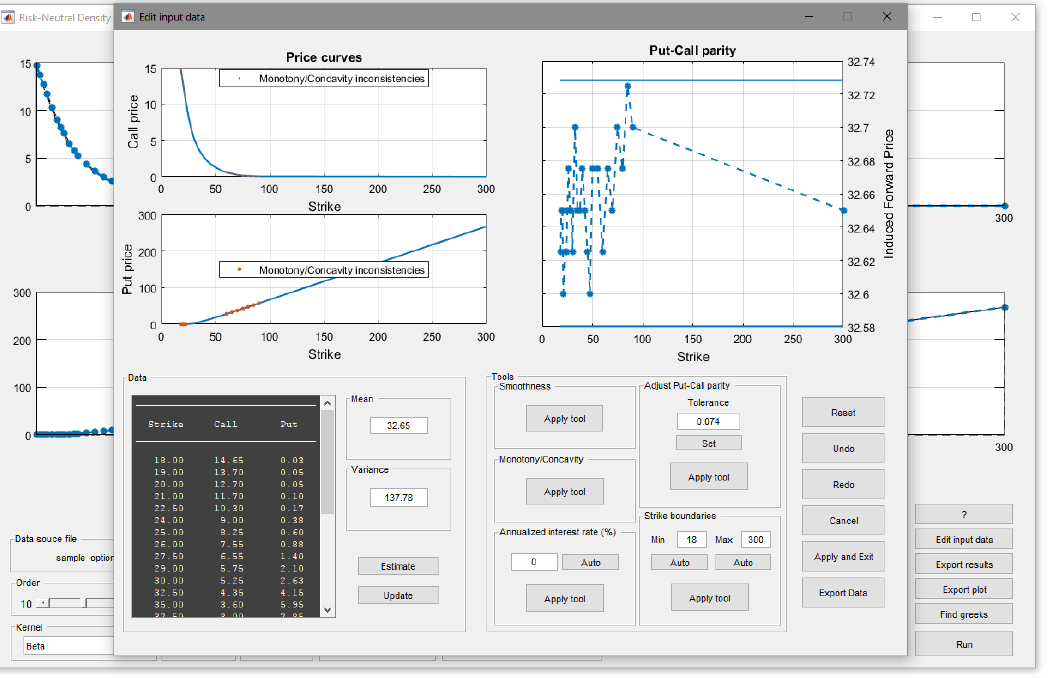
Figure 3. Edit window for VIX options on 16 November